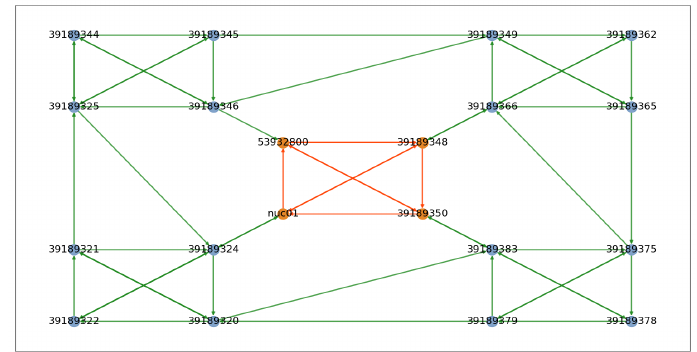
Figure 3. LIC network